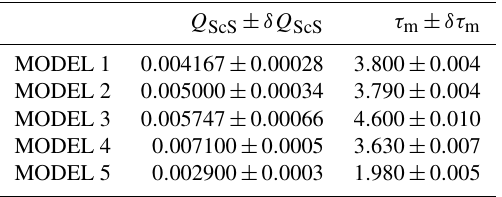
Table 1. Apparent attenuation parameters and their errors estimated for the five simulated models using probability density functions shown in Fig.